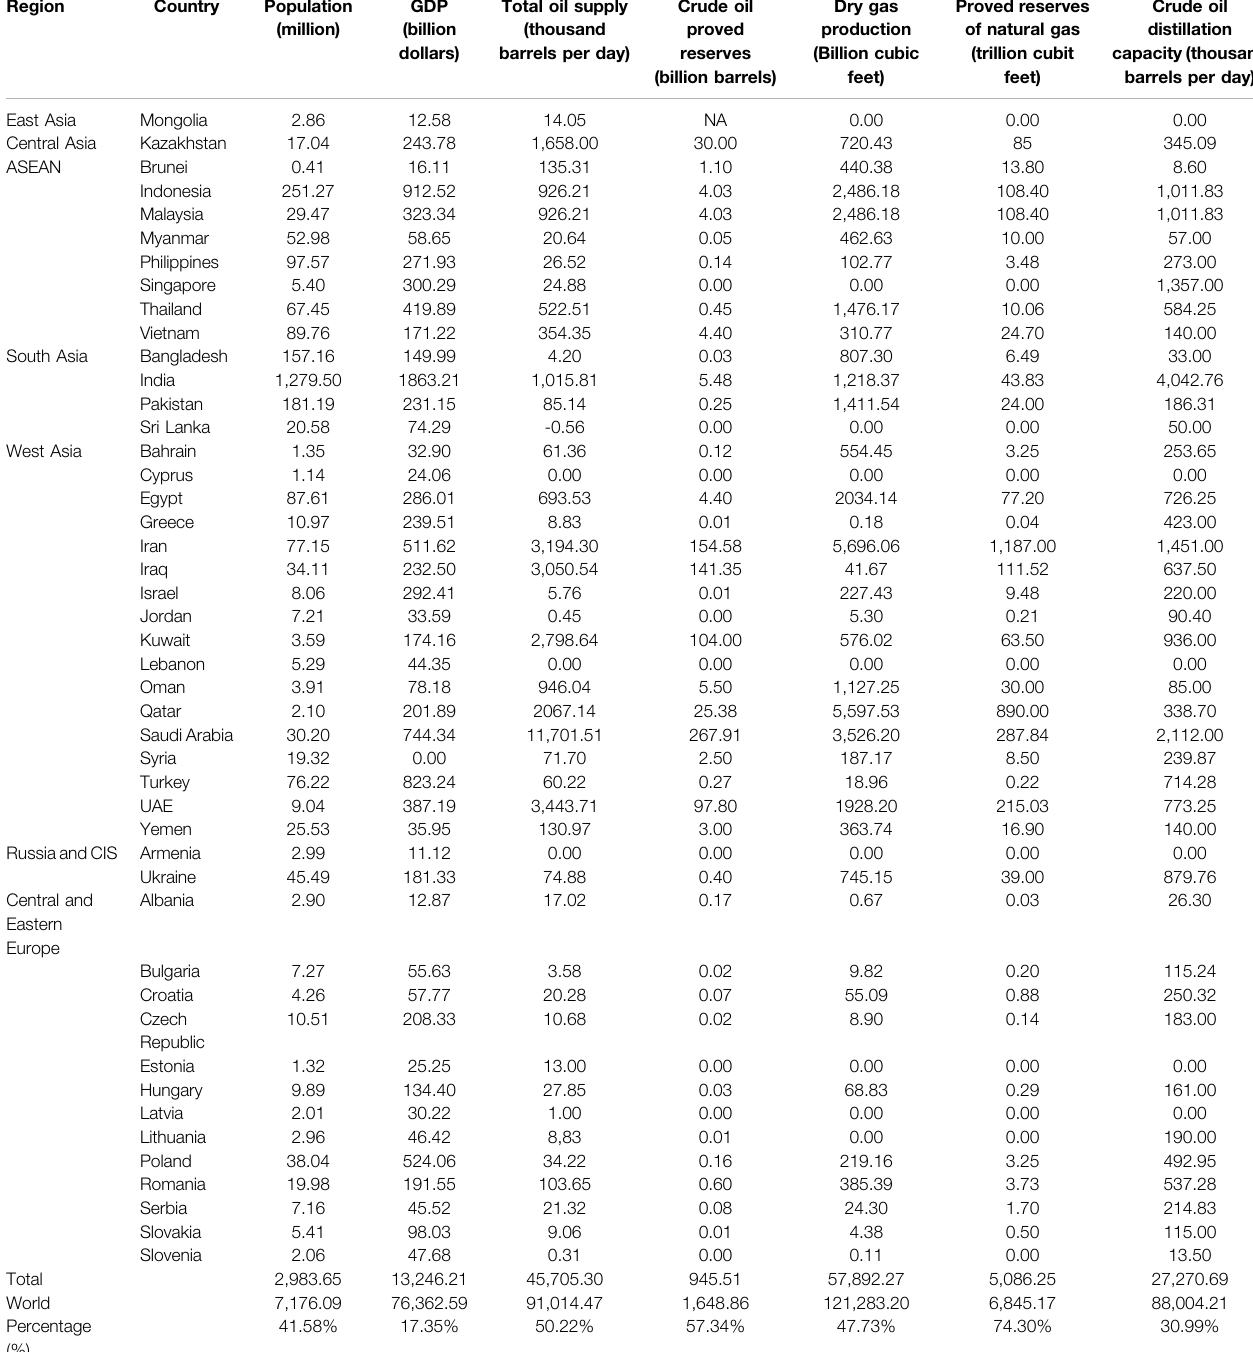
TABLE 2 | Main statistics of 50 Nations alongside the China ’ s “ Belt & Road Initiative ” . Region Country Population